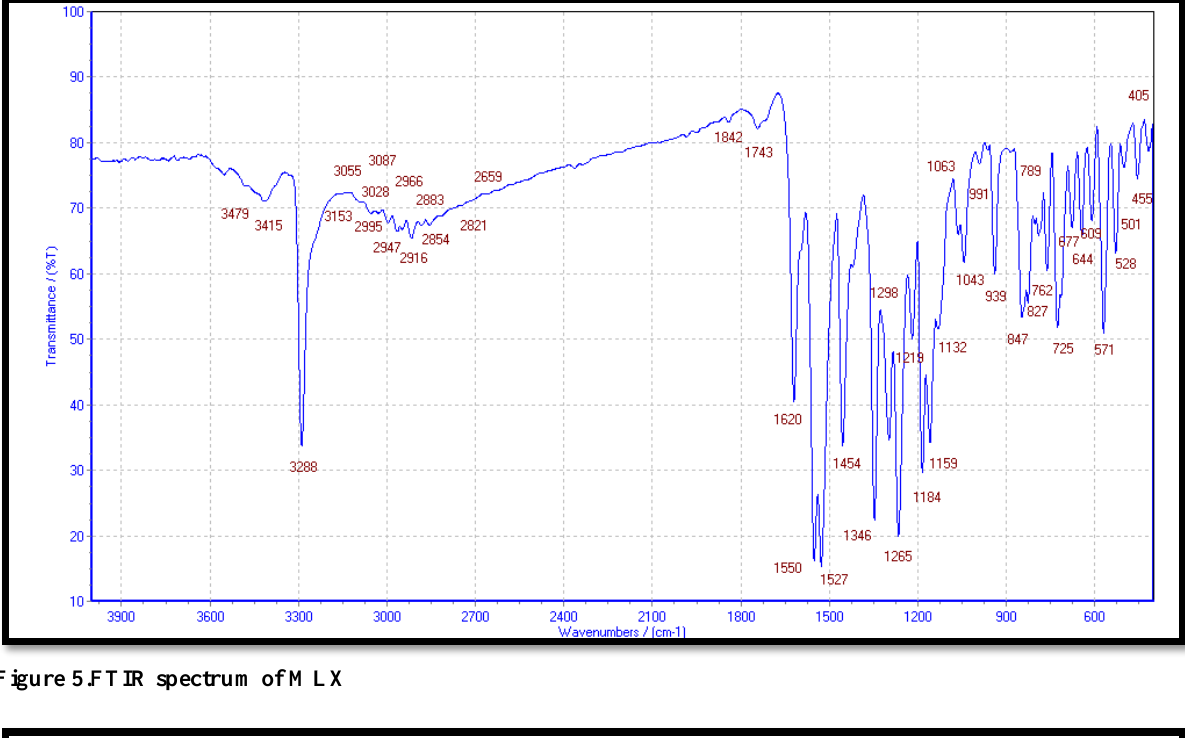
Figure 5.FTIR spectrum of MLX